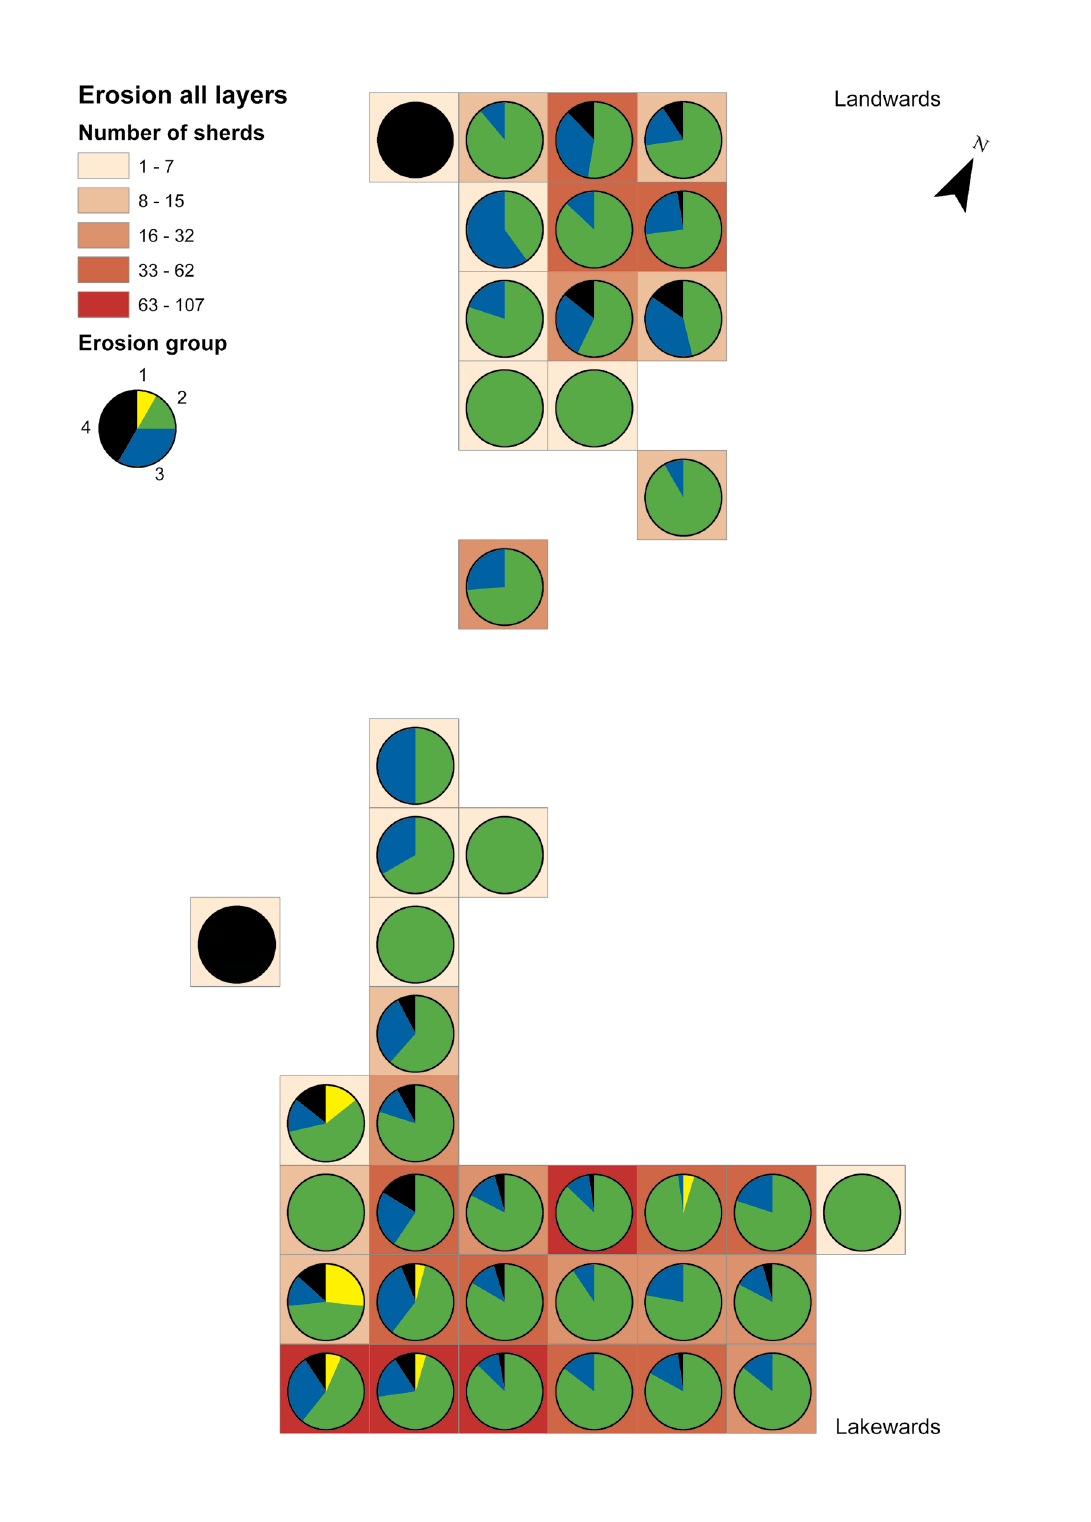
Figure 4. State of erosion/abrasion of sherds by excavated grid